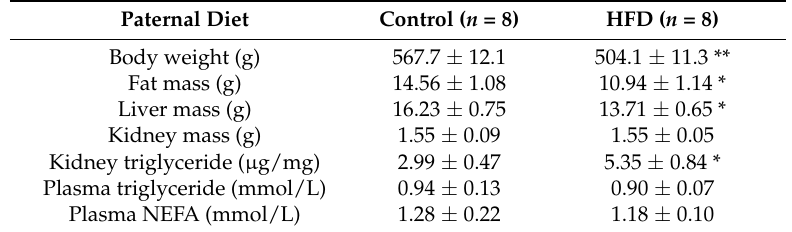
Table 1. Offspring body weight, fat mass, organ mass, and kidney and plasma triglyceride concentrations.